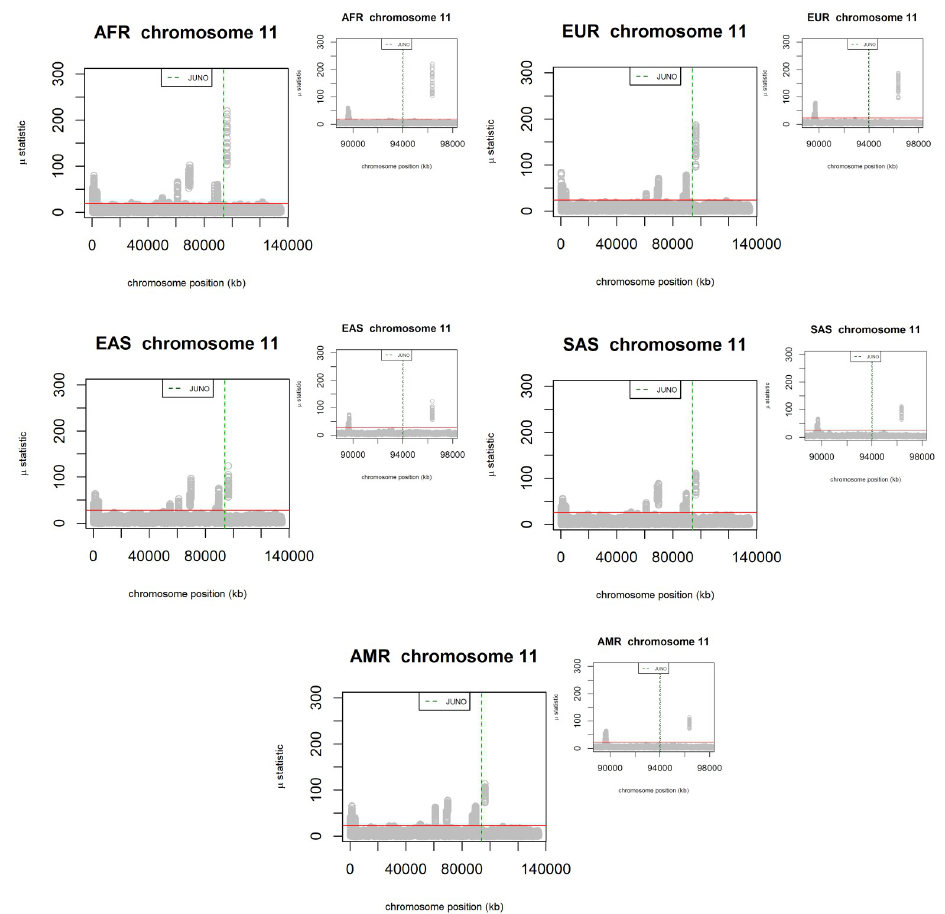
Fig 9. Scanning for signals of positive selection on chromosome 11 of individuals sequenced in the 1000 genomes project belonging to the AFR, EUR, AMR, EAS, and SAS populations. Regions with μ scores above the 99.95% threshold (solid red line) are expected to be under positive selection. The genomic region corresponding to the JUNO gene is marked by green dashed lines. For each population, the larger graph shows the μ scores landscape throughout the entire chromosome, whereas the smaller graph shows the vicinities of the JUNO